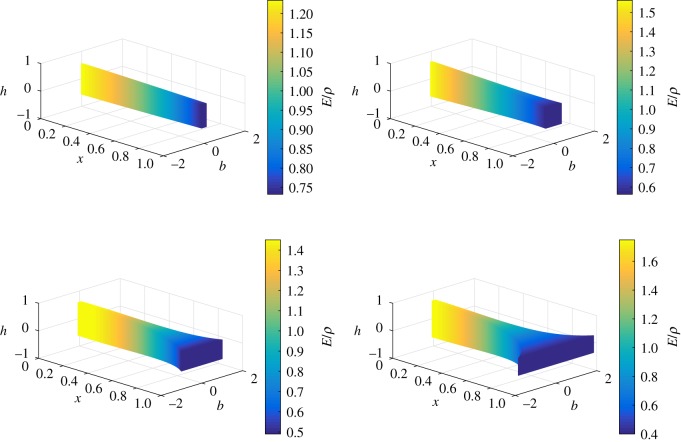
Breadth, height and ratio of modulus and density distributions of non-uniform beams isospectral to a uniform beam (Case 2: α={0.3,0.4,0.5,0.55}, β={0.1,0.2,0.3,0.4}, k=−1, and r0/L=0.09).